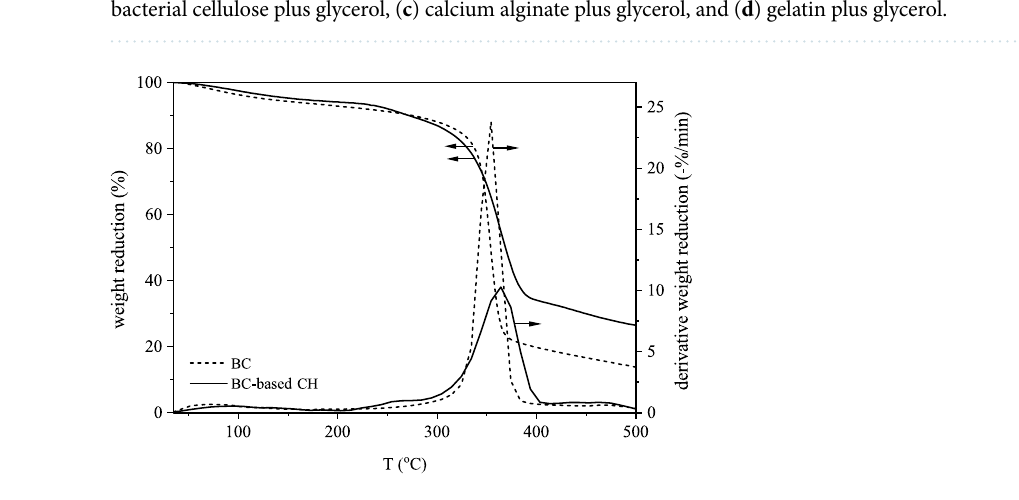
Figure 5. Thermal stability of BC and BC-based CH shown as TGA and first derivative